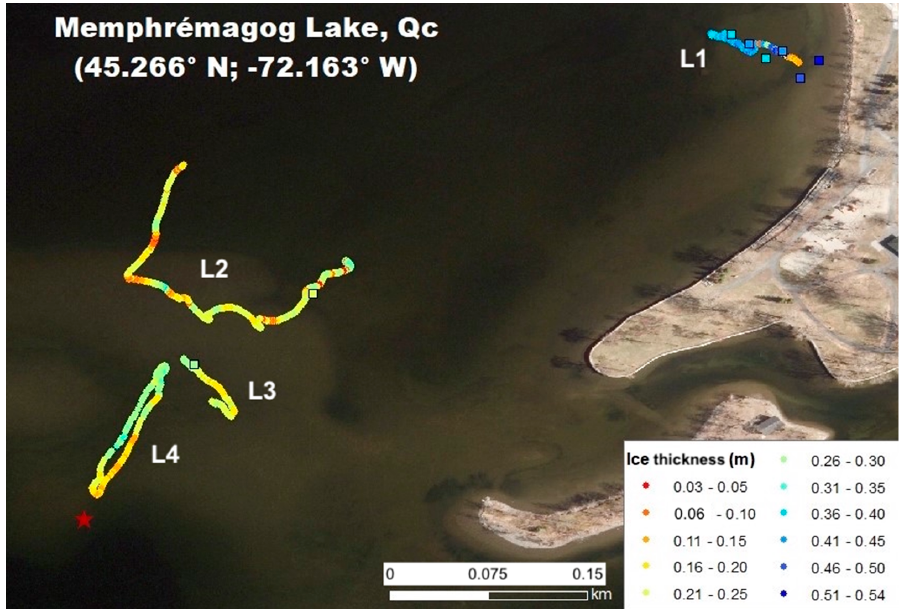
Figure 11. Ice thickness spatial distribution (colors) from in situ measurements (squares) and RPA-based radar data (circles) overlaid on a summer aerial photo. The red star shows the buoy that delimited the open water (see Figure 9). L1 to L4 correspond to the four di ff erent RPA flights. The experiment was performed o ff Pointe-Merry Park, on the right, on Lake Memphremagog, Qu é bec, Canada. Without these two points, the RMSE becomes 1.6 cm with a weak bias of 0.2 cm. This